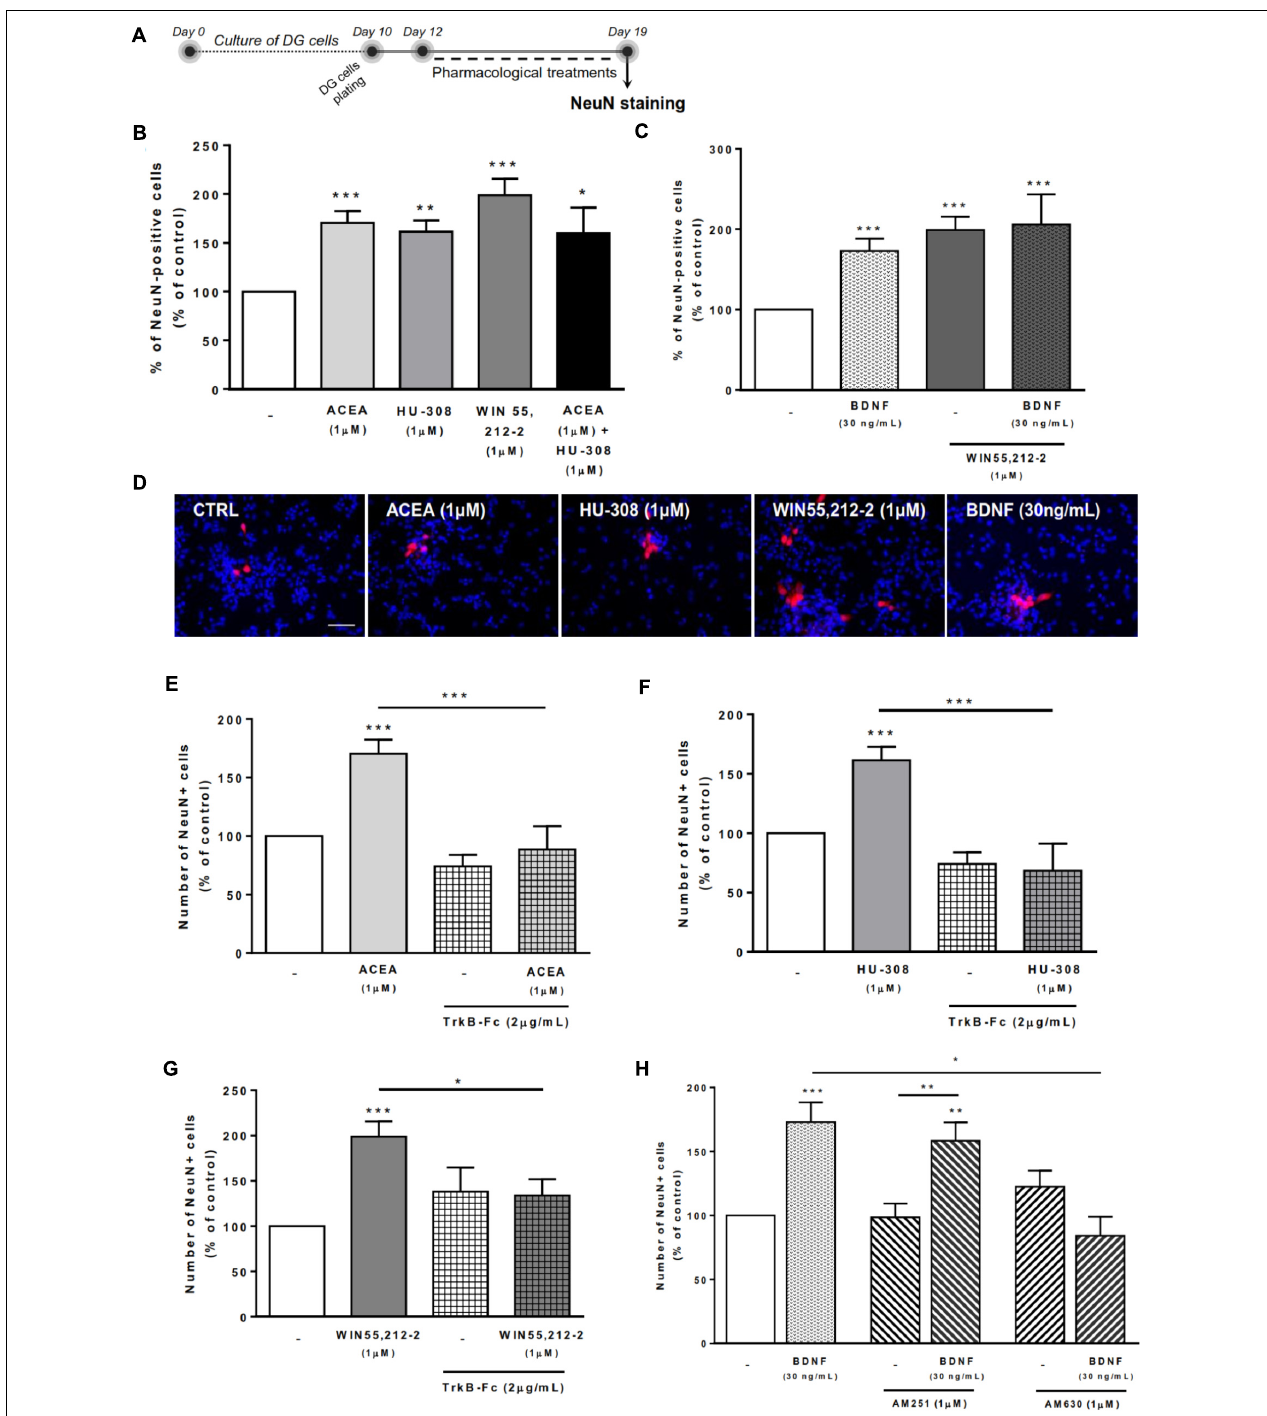
FIGURE 6 | BDNF crosstalk with cannabinoid receptors tightly regulates DG neuronal differentiation. DG neuronal differentiation was increased upon cannabinoid receptor activation. BDNF was required for cannabinoid receptor-mediated effect on DG neuronal differentiation. CB2R, but not CB1R, antagonism blocked the effect promoted by BDNF upon SVZ neuronal differentiation. (A) Schematic representation of the experimental protocol. Day 0 represents the day of cultures; at Day 10 DG neurospheres were plated for 48 h and at Day 12 cells were exposed to pharmacological treatments for further 7 days (Day 19). (B,C,E–H) Bar graphs depict the percentage of NeuN-positive cells. Values were normalized to the control mean for each experiment and are represented as mean ± SEM. Control was set to 100%. n = 6–19. ∗ p < 0.05 and ∗∗∗ p < 0.001 using Dunnett’s multiple comparison test. (D) Representative fluorescent digital images of cells immunopositive for NeuN (in red) and Hoechst 33342 staining (blue nuclei). Scale bar = 50 µ m.